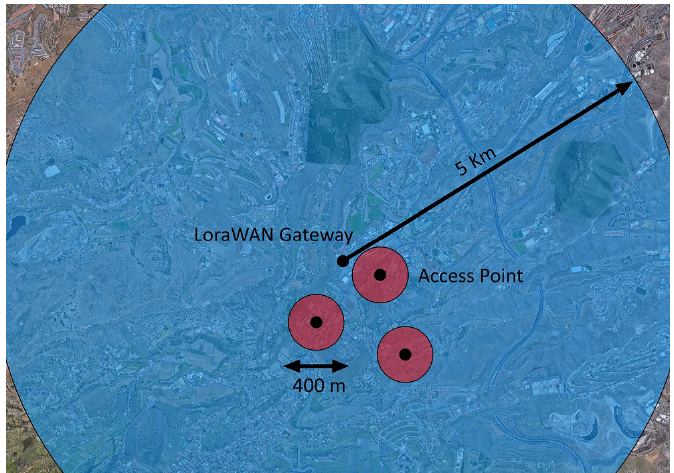
Figure 14. Simulated coverage maps approximated using the Okumura–Hata model for LoRaWAN (blue), and the general urban path loss (GUPL) model for ZigBee (red). The estimations are overlaid to the environment’s satellite image. The transmitter locations are